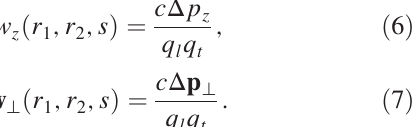
FIG. 11. Simulated collimator structure in CST . The beam simulated to generate and probe the wake potentials has the same properties of the witness bunch so far described.